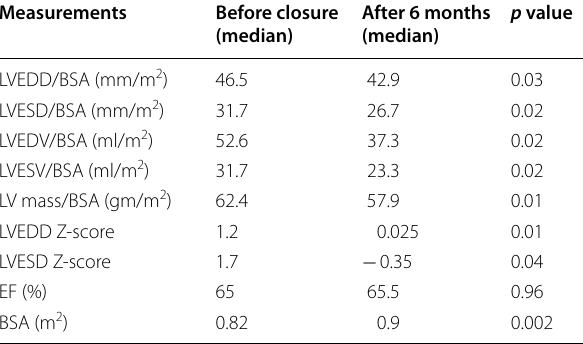
AV-VSD: Distance between VSD and rim of Aortic valve, F: female, M: male, Qp/Qs: ratio of pulmonary blood flow to systemic blood flow, VSD: ventricular septal defect